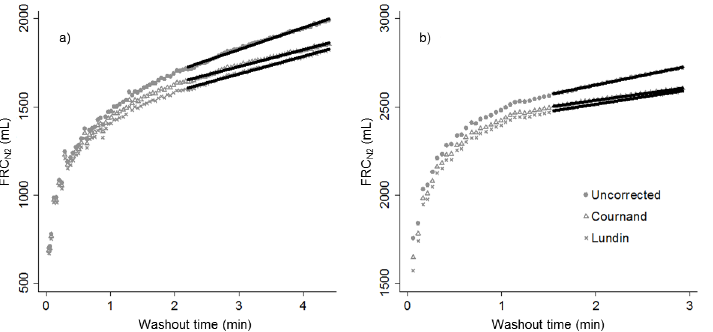
Fig 4. Representative examples of FRC N2 plotted against washout time in a) a healthy subject and b) a patient with CF . Applicationof the Cournand and Lundintissue N 2 excretionequationsresultedin a less pronounced increase in the calculationof FRC N2 over the course of the washout, but a plateauwas never achieved.Linearregressions of these curves over the second half of the washout are shown, demonstrating the slopes that are reportedin Table 4.